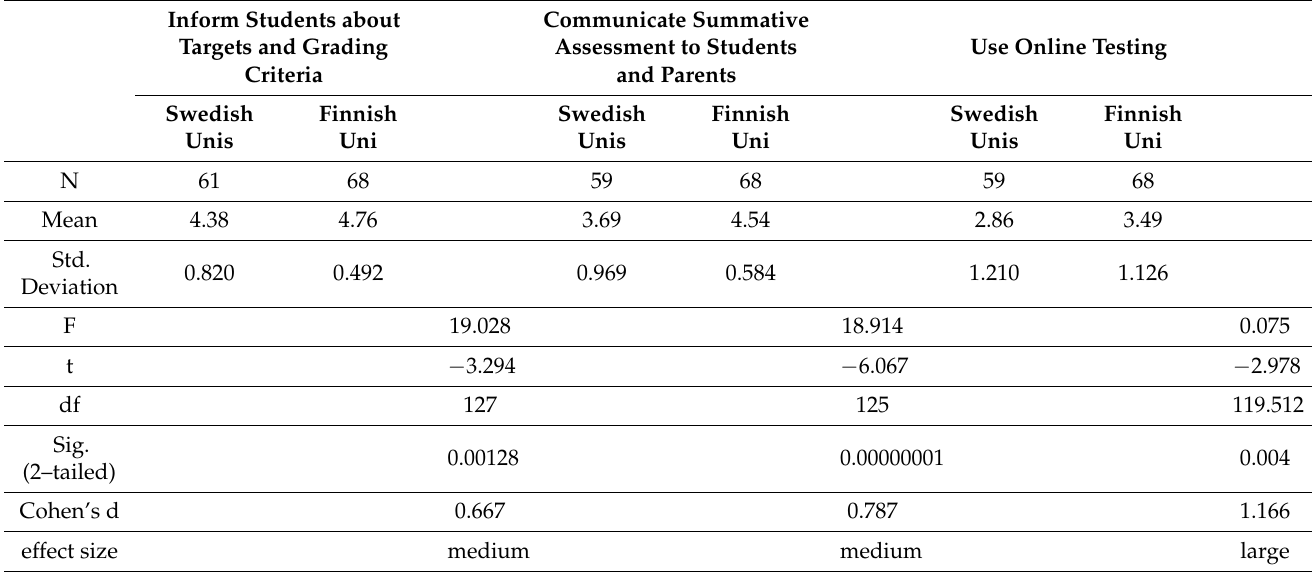
Table 5. Differences between the Swedish and the Finnish universities in how important the pre- service teachers considered summative assessment